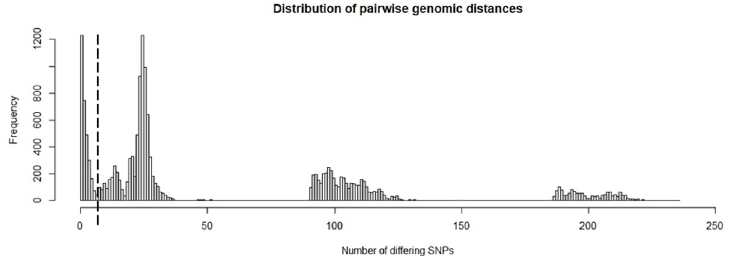
Fig 2. Distribution of pairwise genomic distances (n = 150 isolates with 1,472 SNPs). The dashed line marks the genomic distance threshold of 6 SNPs.